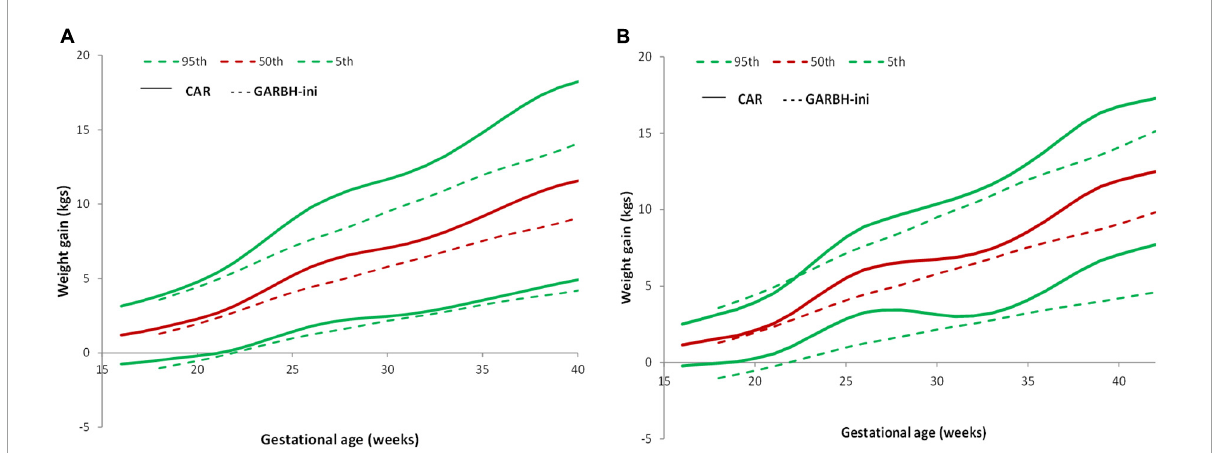
FIGURE5 Pattern of GWG and their comparison with GARBH-Ini cohort. (A) Comparison of GWG curves of the REVAMP cohort ( n = 640) with GARBH-Ini by gestational age. (B) Comparison of GWG curves of the REVAMP cohort low-risk population ( n = 102) with GARBH-Ini reference.